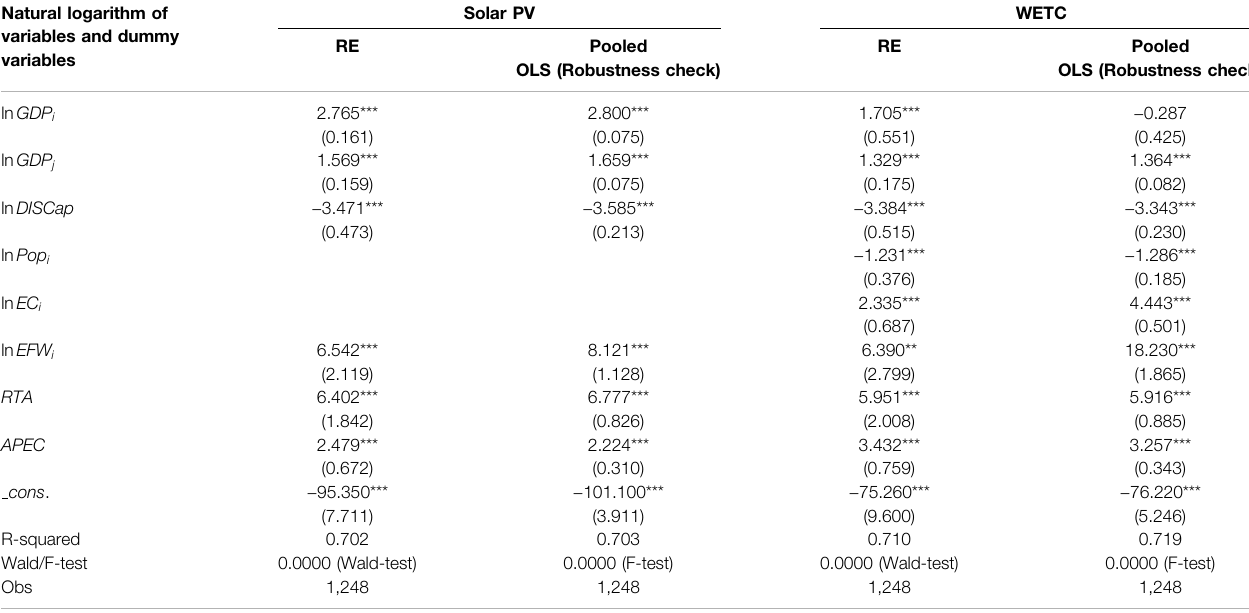
TABLE 7 | Separate regression results for estimating export ef fi ciency and export potential of solar PV and WETC goods. Natural logarithm of variables and dummy variables